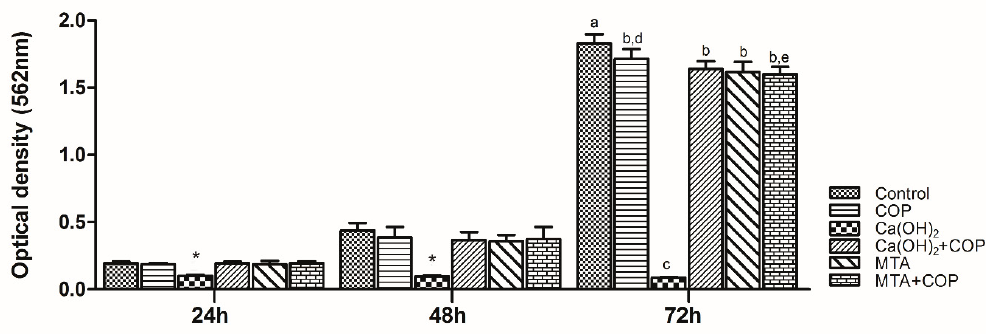
Figure 3. Graphic representation of the mean cell viability (optical density) in all of the experimental groups throughout the experimental time. * The Ca(OH) 2 group presented the smallest values over the duration of the experiment ( p < 0.01). Different letters indicate significant differences among the groups at 72 h ( p < 0.01). Bars indicate the standard error of the mean.